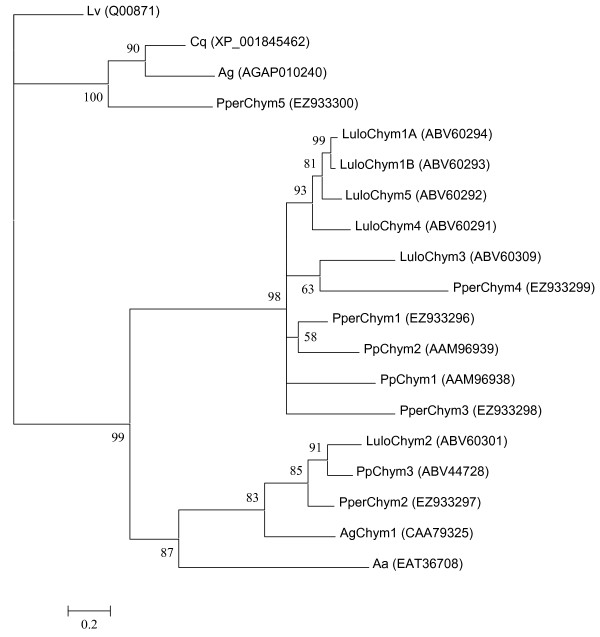
Phylogenetic analysis of putative chymotrypsin molecules from Litopenaeus vannamei (Lv), Culex quinquefasciatus (Cq), Anopheles gambiae (Ag), Aedes aegypti (Ae), Phlebotomus perniciosus (Pper), Lutzomyia longipalpis (Lulo) and Phlebotomus papatasi (Pp). GenBank accession numbers are given in parentheses and node support indicated by the bootstrap value.